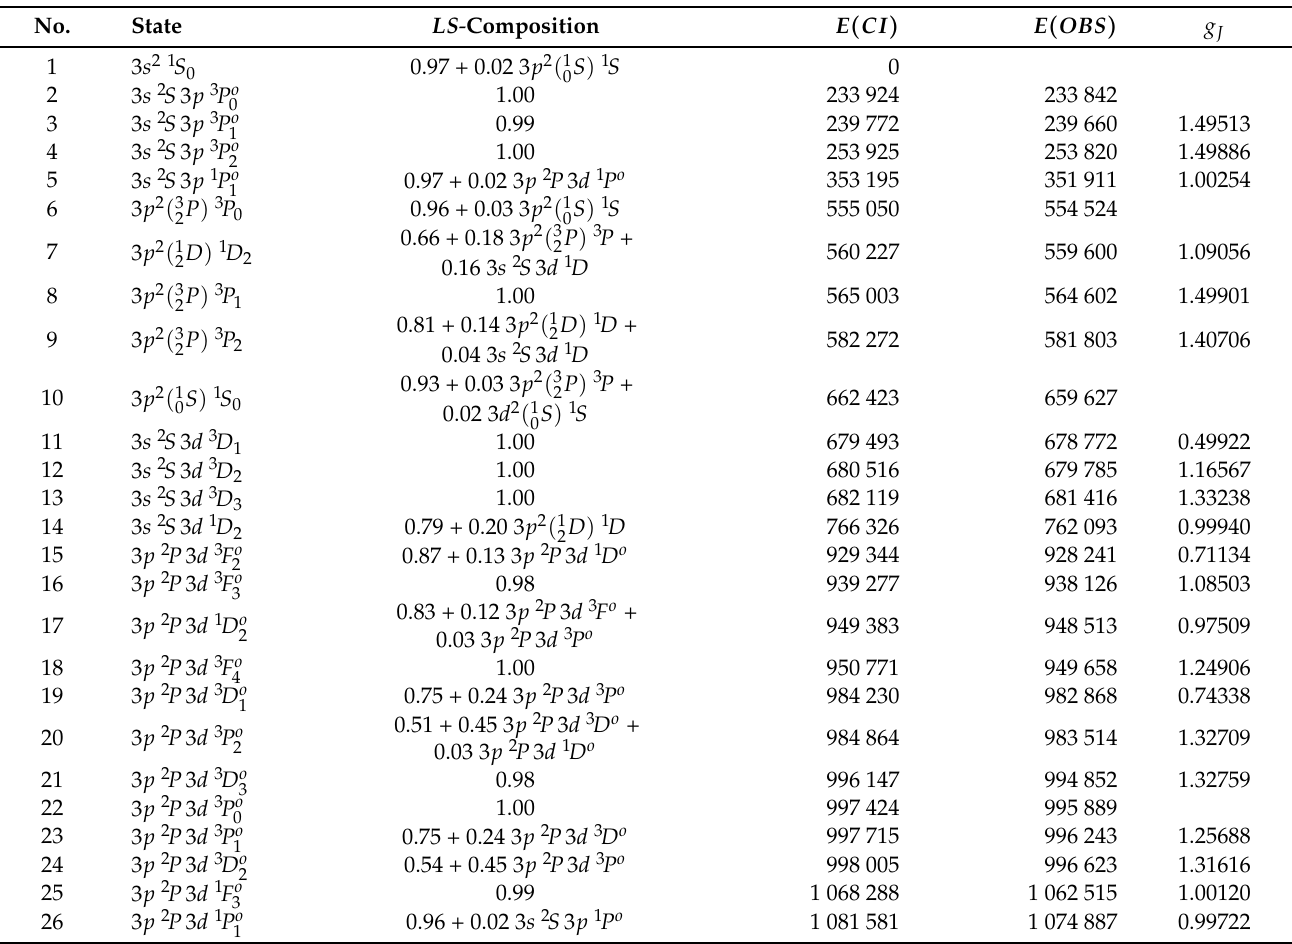
Table 6. Energies in cm − 1 and Landé g J -factors for states in Mg-like